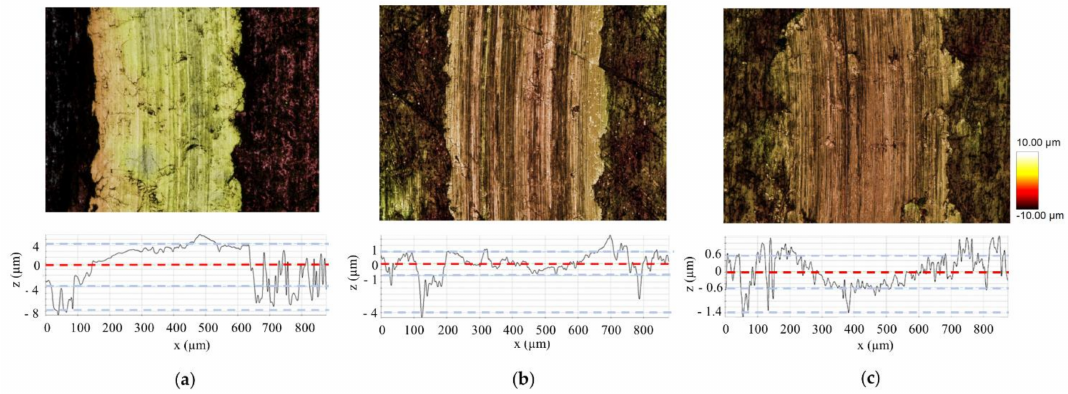
Figure 6. Optical profilometry of wear tracks for the GHA / 100Cr6 system: ( a ) GHA10, ( b ) GHA50 and ( c )